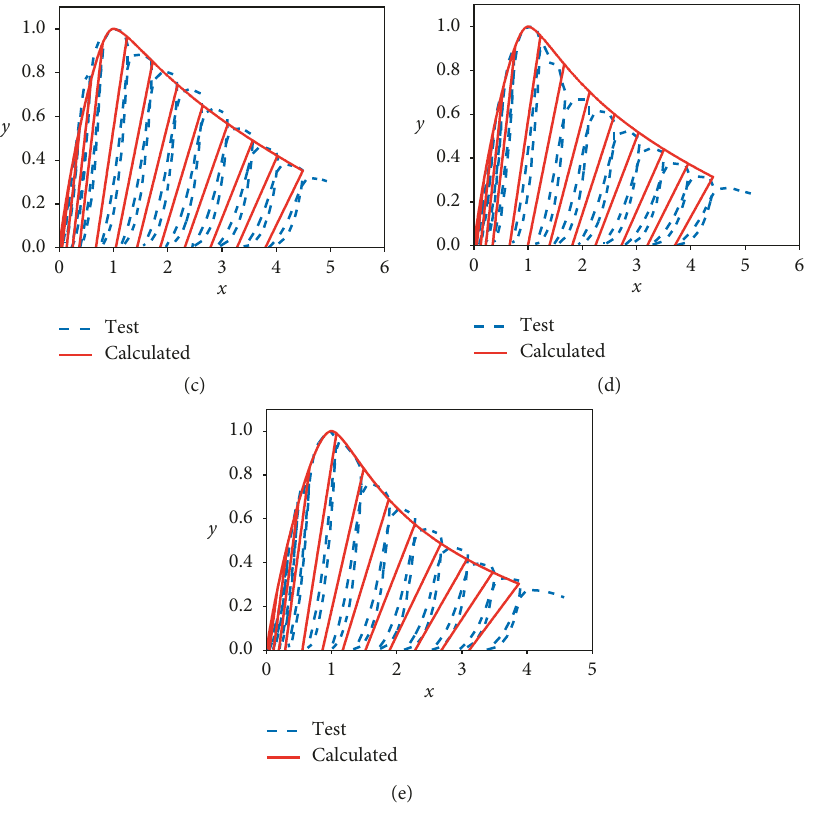
Figure 17: Verification of the proposed model in the case of cyclic loading using the test results in this study. (a) NAC ( r � 0). (b) RAC-25 ( r � 25%). (c) RAC-50 ( r � 50%). (d) RAC-75 ( r � 75%). (e) RAC-100 ( r � 100%).